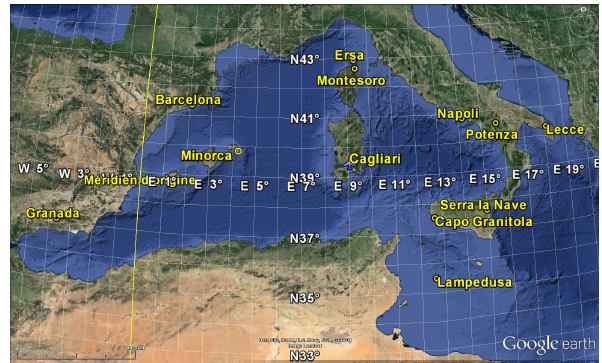
Figure 2. The regional experimental setup deployed in the western and central Mediterranean during the ChArMEx SOP-1a campaign. The two aircraft were based at